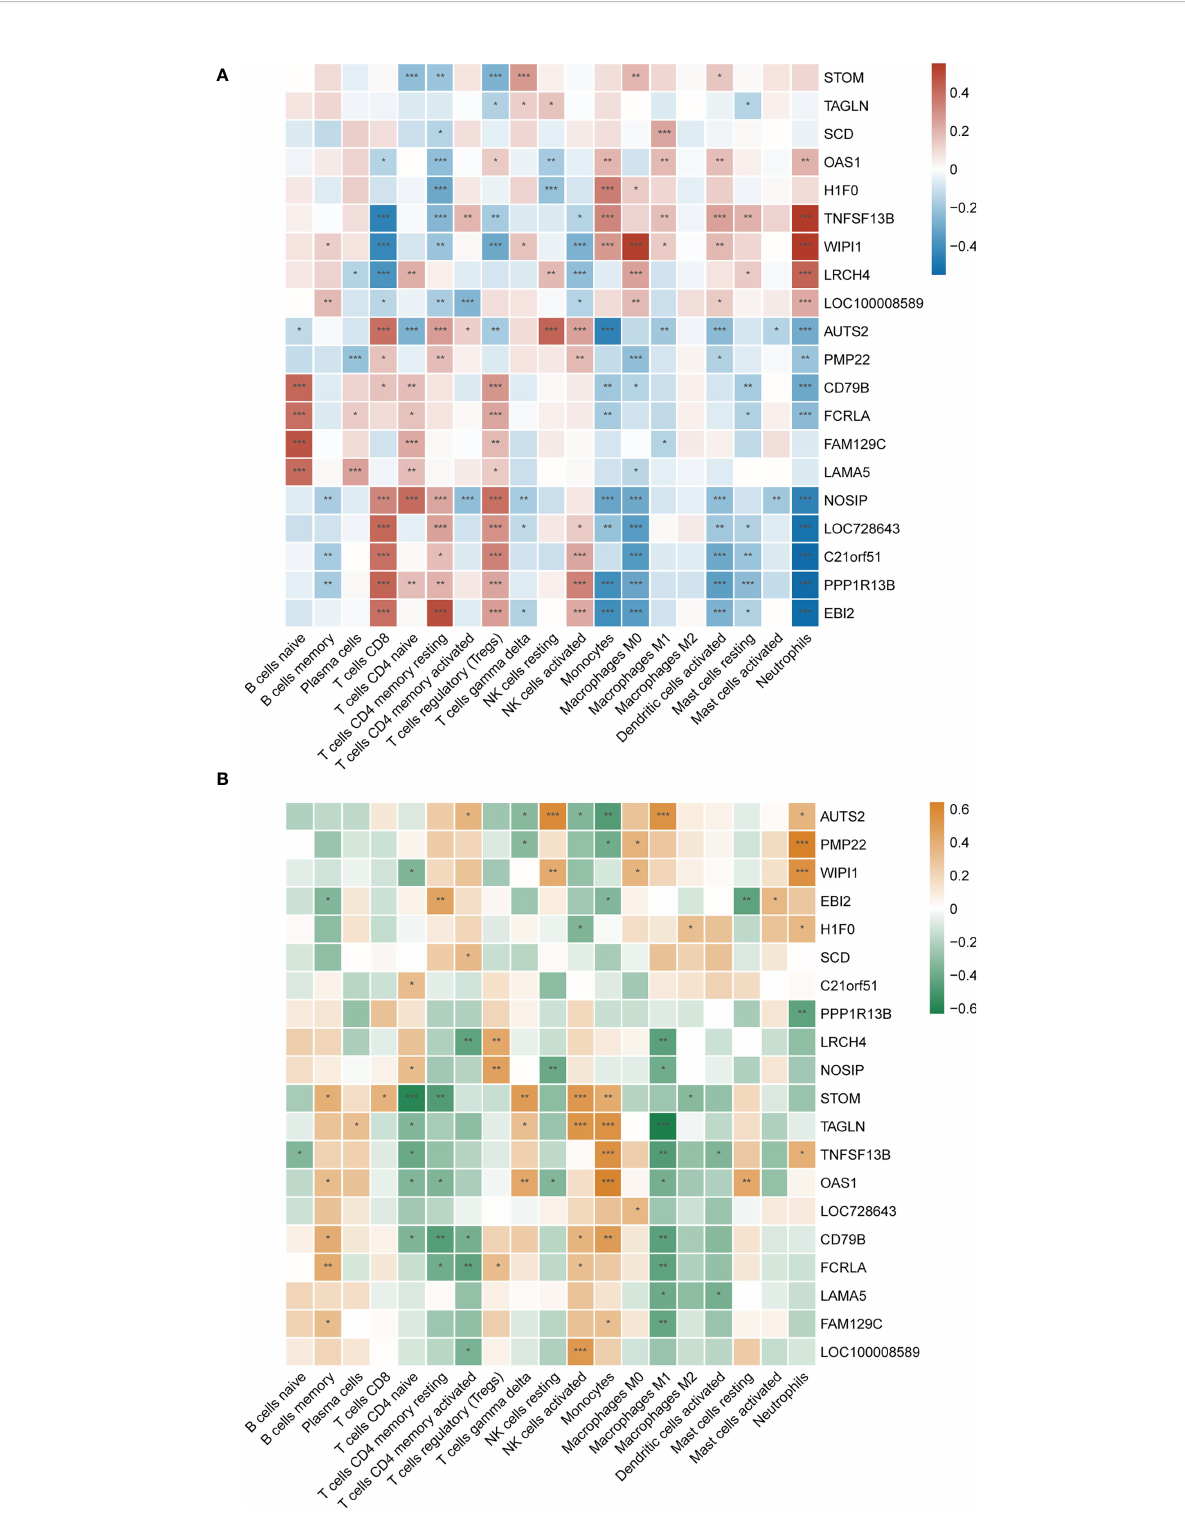
FIGURE 8 (A) Correlation matrix between immune cell proportions and shared hub genes in SLE. Red represents for positive correlation, while blue for negative correlation. (B) Correlation matrix between immune cell proportions and shared hub genes in MetS. Orange represents for positive correlation, while green for negative correlation. Asterisks represent levels of signi fi cance (*p < 0.05, **p < 0.01, ***p <